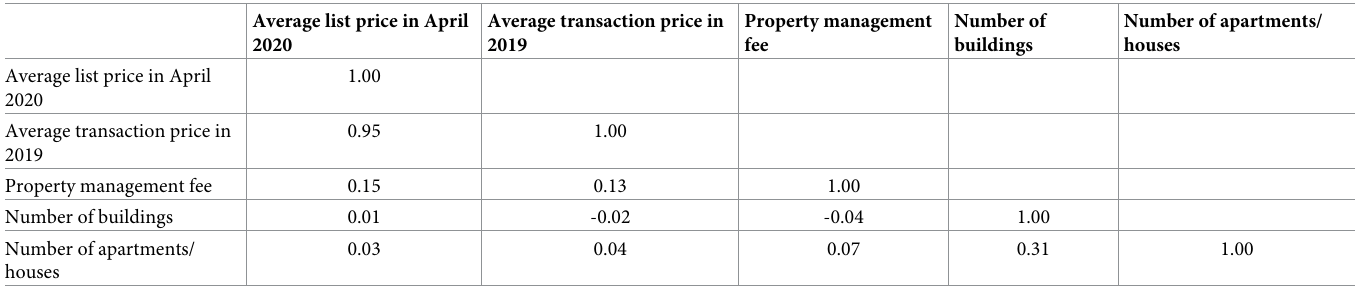
Table 2. Correlation between housing price, property management fee, and neighborhood